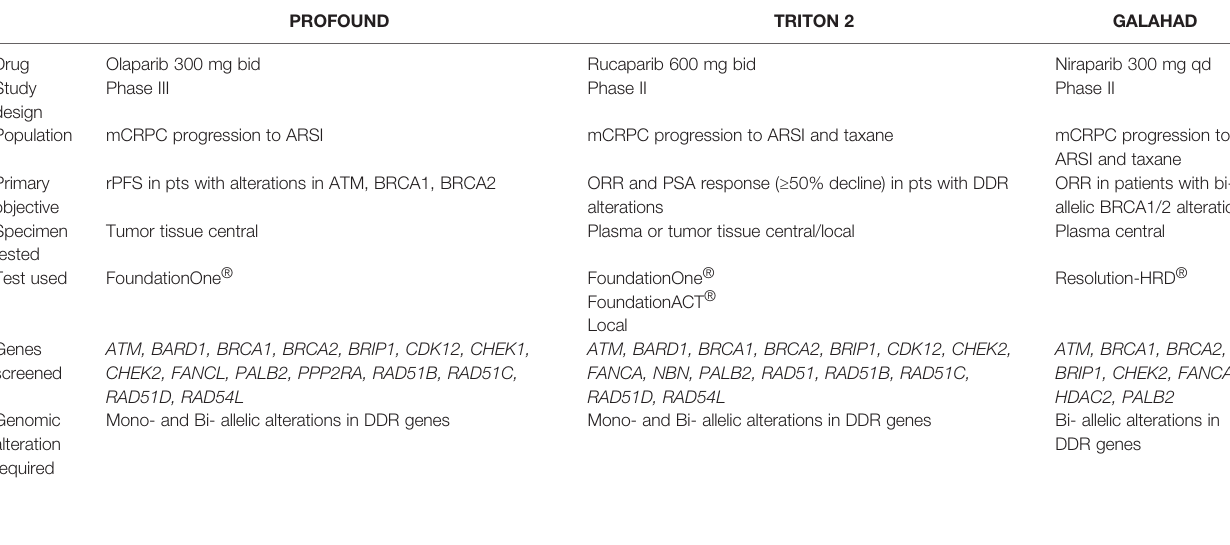
TABLE 2 | Trials screening genes involved in prostate cancer (PCa) registered within clinicaltrials.gov database (December 2021). See text for